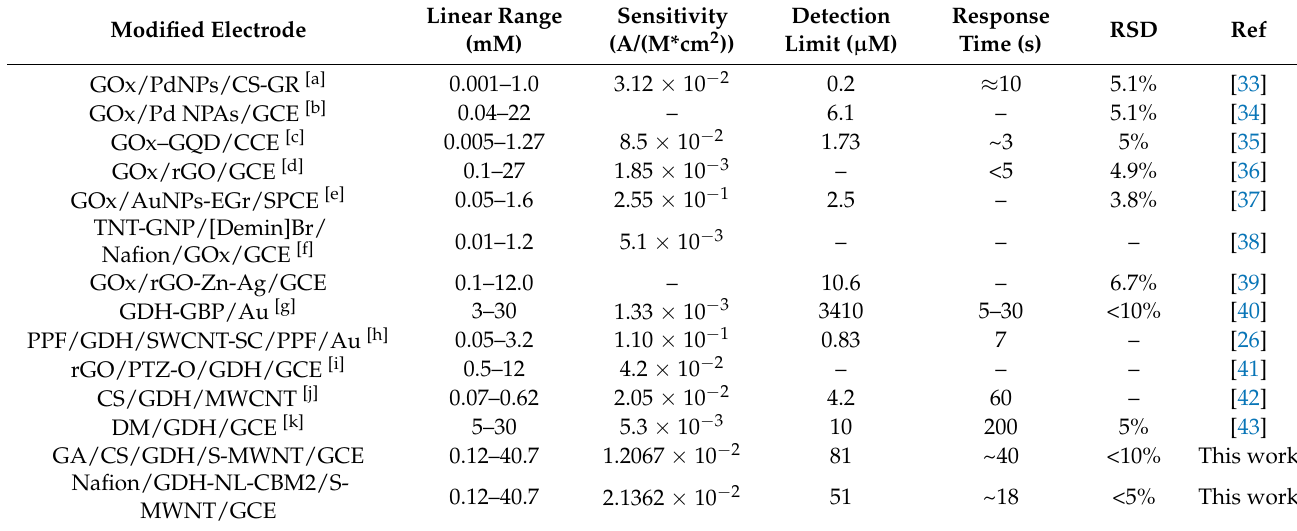
Table 1. Comparison of the performance parameters of the glucose biosensors based on GOx and FAD-GDH. Modified